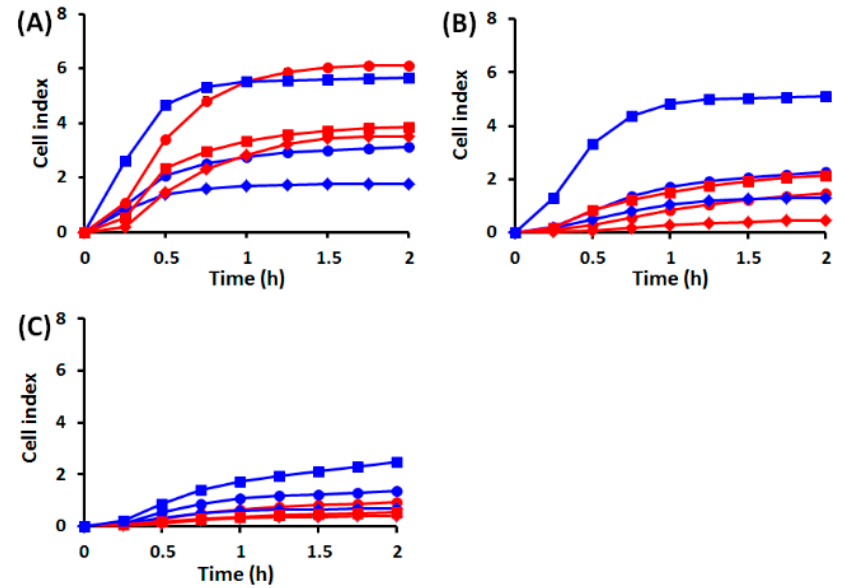
Figure 1. Kinetics of cell adherence and spreading for HaCaT (red plots) and DOK (blue plots) cells, on various matrix proteins, at different concentrations. ( A ) Collagen; ( B ) fibronectin; ( C ) laminin; diamonds—2.5 µg/mL, circles—5 µg/mL, squares—10 µg/mL.